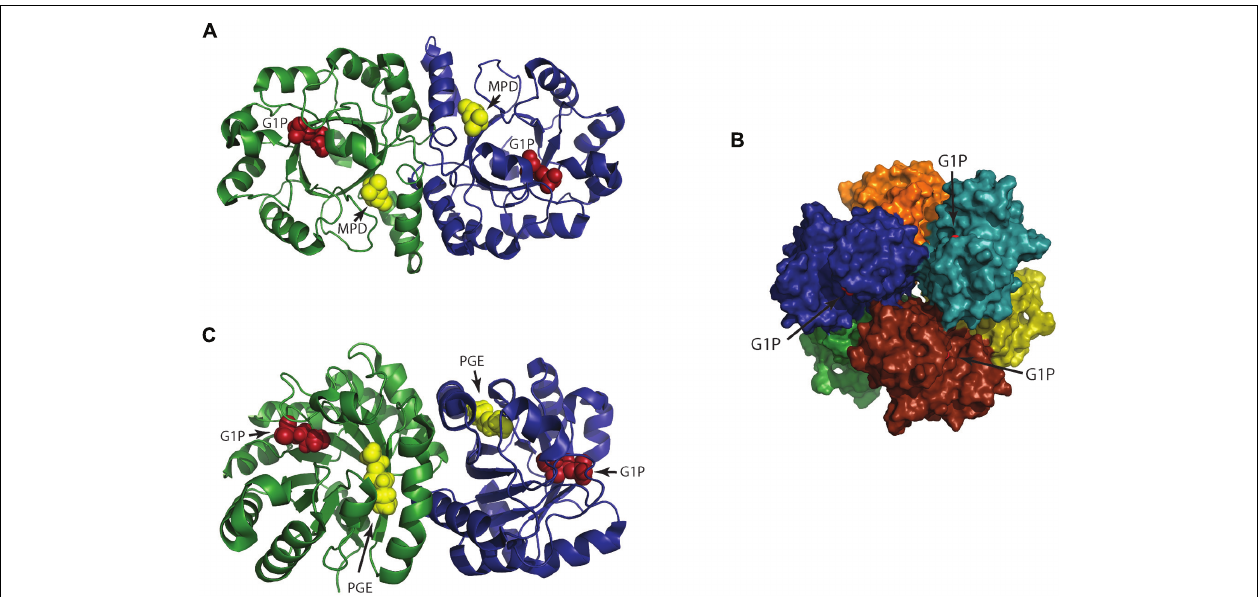
FIGURE 3 | Structure of 3- O -geranylgeranyl- sn -glyceryl-1-phosphate synthase (GGGP synthase). (A) Crystal structure of group I dimeric GGGP synthase from Archaeoglobus fulgidus solved at 2.0 Å resolution (PDB: 2F6X) has a novel TIM-barrel modification (Payandeh etal., 2006). Sn -glycerol-1-phosphate (G1P) and a cryoprotectant (MPD) used in the experiment are colored as red and yellow spheres respectively. The cavity for MPD likely represents the binding site for the second substrate geranylgeranyl diphosphate (GGPP). (B) Crystal structure of group II GGGP synthase from Methanothermobacter